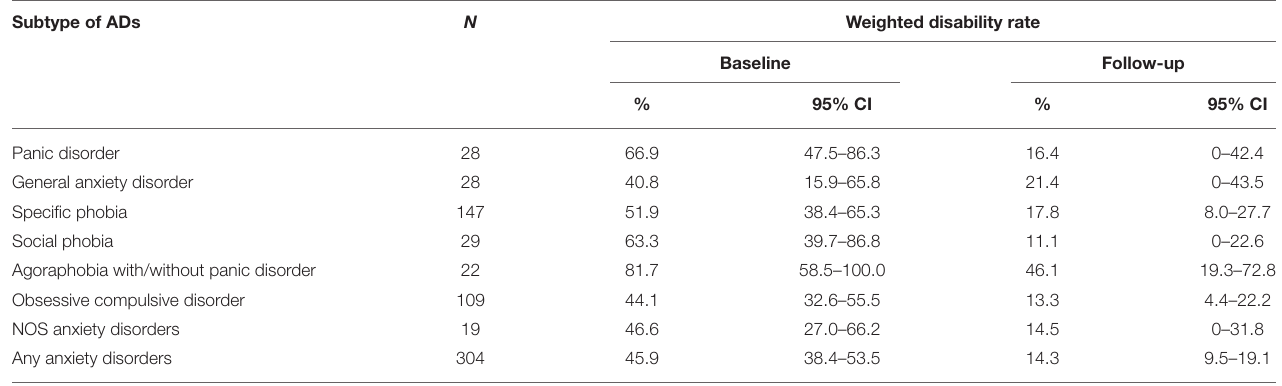
TABLE 1 | The weighted disability rate at baseline and follow-up in ADs patients.